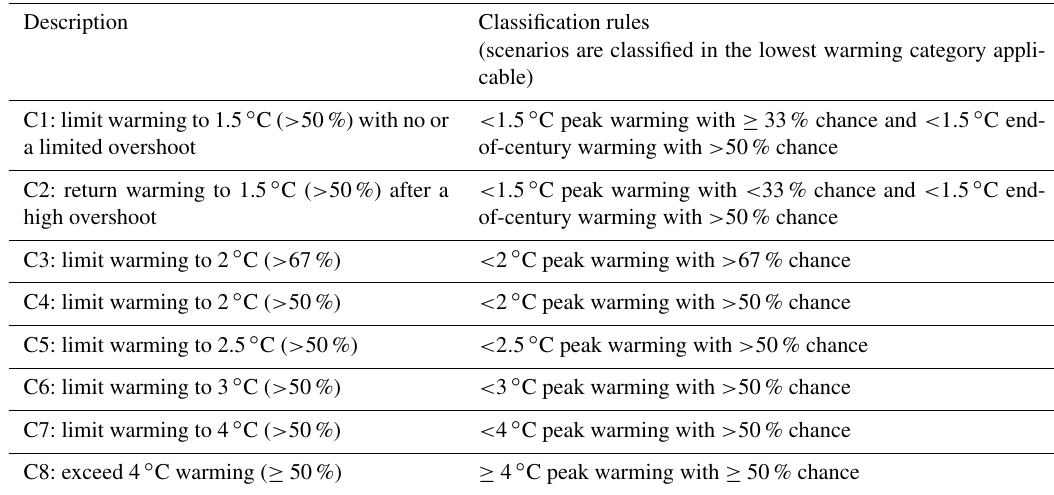
Table 2. Temperature classification rules used in AR6 WGIII, where a scenario is placed in the lowest category where it meets the classifi- cation